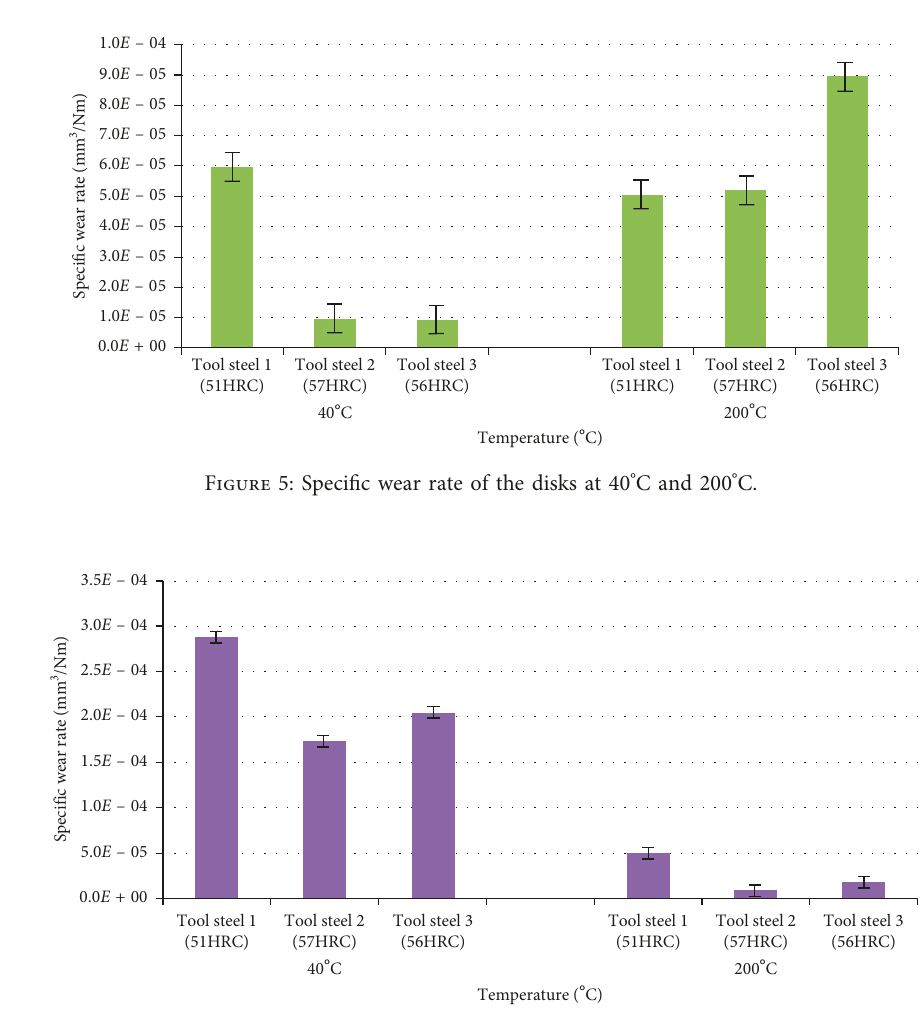
Figure 6: Specific wear rate of the pins at 40 ° C and 200 °